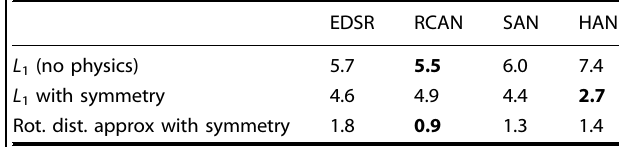
Lower values indicate better performance, with ground truth containing approximately 0.2% single-pixel features. Physics-based loss reduces noise,